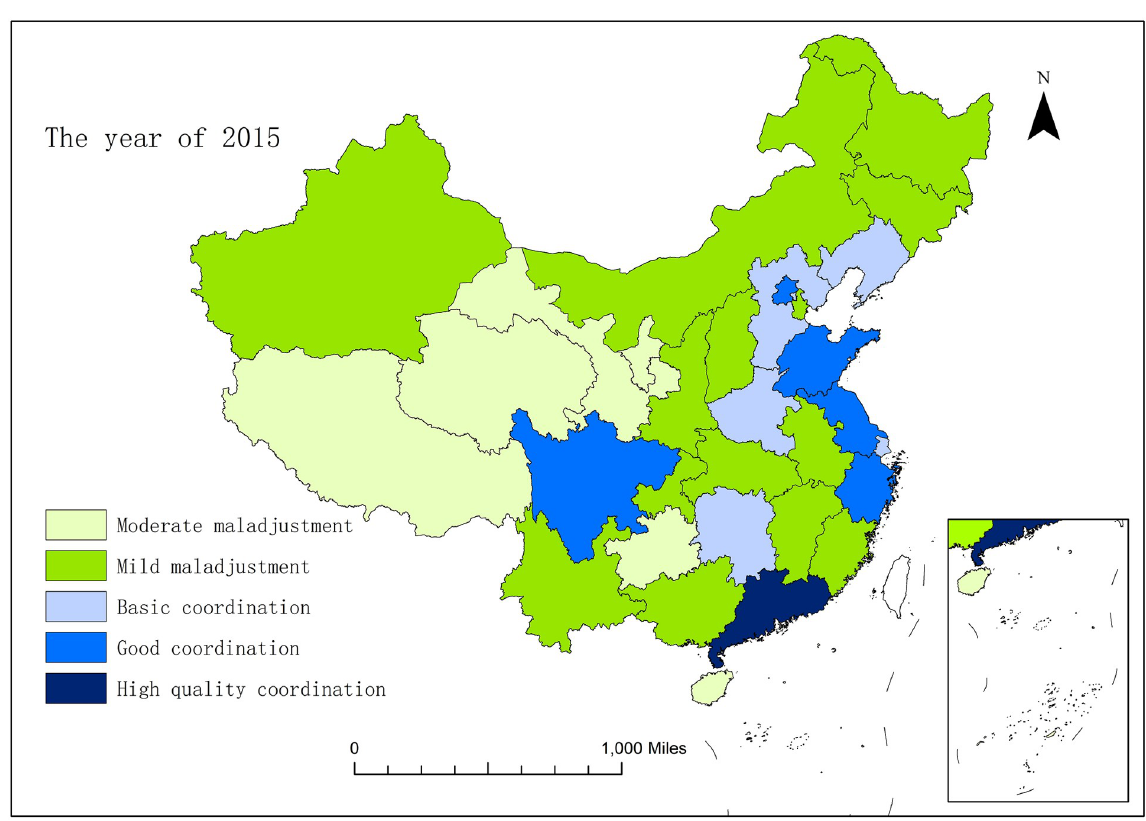
Fig 4. The spatial pattern of coupling and coordination of the sports industry and health service industry in 31 provinces and cities of China in the year of 2015.